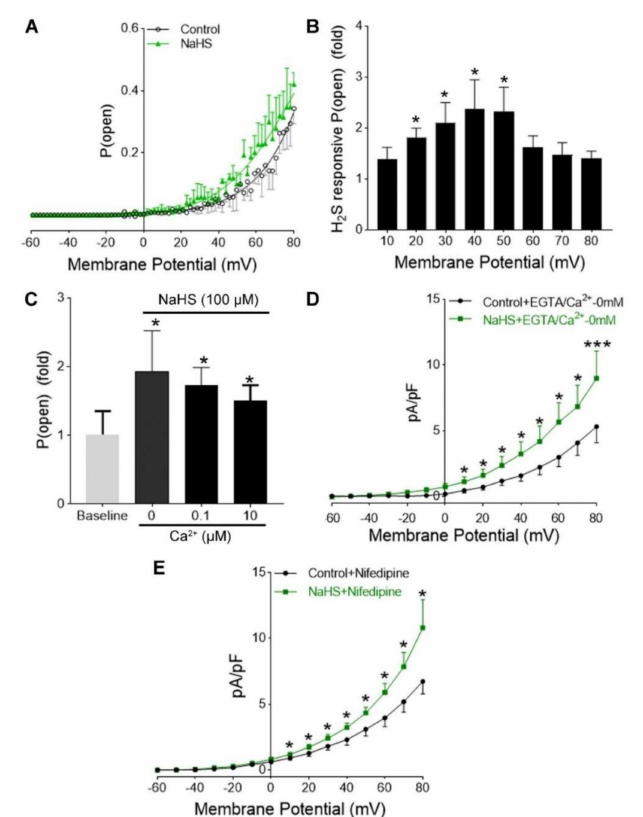
Figure 4. Properties of H 2 S-responsive BK Ca in hUASMC in vitro. ( A ) Open probability ( P open ) of BK Ca recorded with membrane potential of − 60 mV to + 80 mV in outside-out single-channel mode. ( B ) P open with di ff erent membrane potentials with and without 100 µ M NaHS. NaHS increased P open with membrane potential of + 20 to + 50 mV. * p < 0.05, NaSH vs. control at each membrane potential ( n = 8). ( C ) Ca 2 + concentrations (0, 0.1, and 10 µ M) in pipette solution on P open of BK Ca channels in response to NaHS at − 60 mv membrane potential. * p < 0.05 vs. baseline. ( D ) Bath solution with 5 mM EGTA on current density in response to NaHS at − 60 mv membrane potential. NaHS ( n = 11) increased current density in free Ca 2 + bath solution. * p < 0.05, *** p < 0.001 vs. control; n = 11 / group. ( E ) E ff ects of nifedipine (5 µ M) in bath solution on NaHS (100 µ M)-induced current density. * p < 0.05 vs. control; n = 6 /